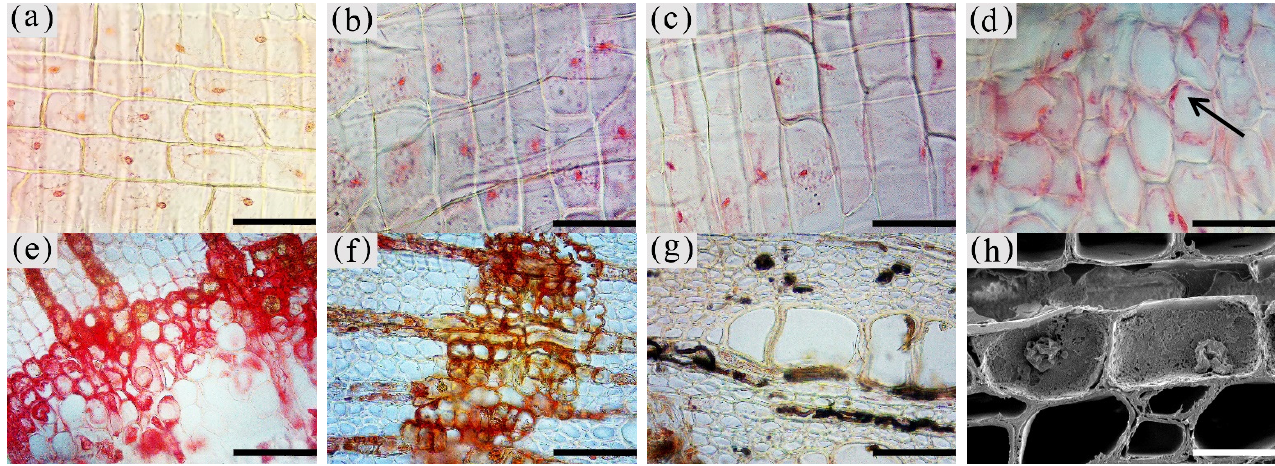
Figure 4. Color development of the nuclei of parenchyma cells in the xylem of A. sinensis . ( a ) Nuclei in the blank control. ( b ) Nuclei in the medialis xylem rays of the white zone. ( c ) Nuclei in the xylem rays of the transition zone. ( d ) Nuclei in the interxylary phloem of the transition zone. ( e ) Medialis of transitional zone transverse surface without the nucleus. ( f ) No nuclei were observed in the agarwood zone. ( g ) No nuclei were observed in the decay zone. ( h ) Highly crumpled nuclei in the transition zone. Scale bars = ( a – d ) 50 µ m; ( e – g ) 80 µ m; ( h ) 25 µ m.